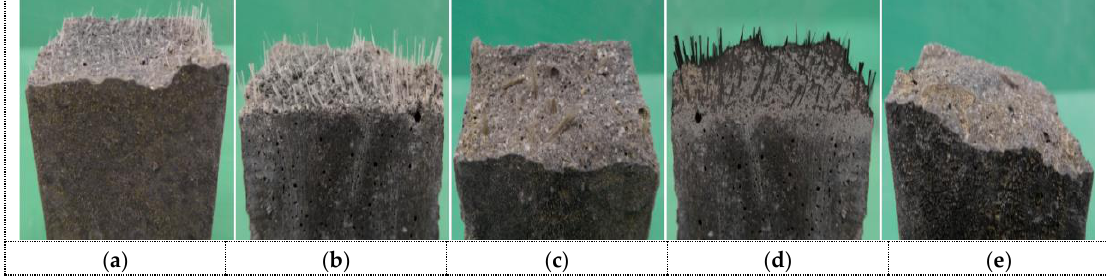
Figure 6. Test samples of the three-point bending tensile strength after 14 days. ( a ) E-glass; ( b ) AR- glass; ( c ) basalt; ( d ) carbon; ( e ) No